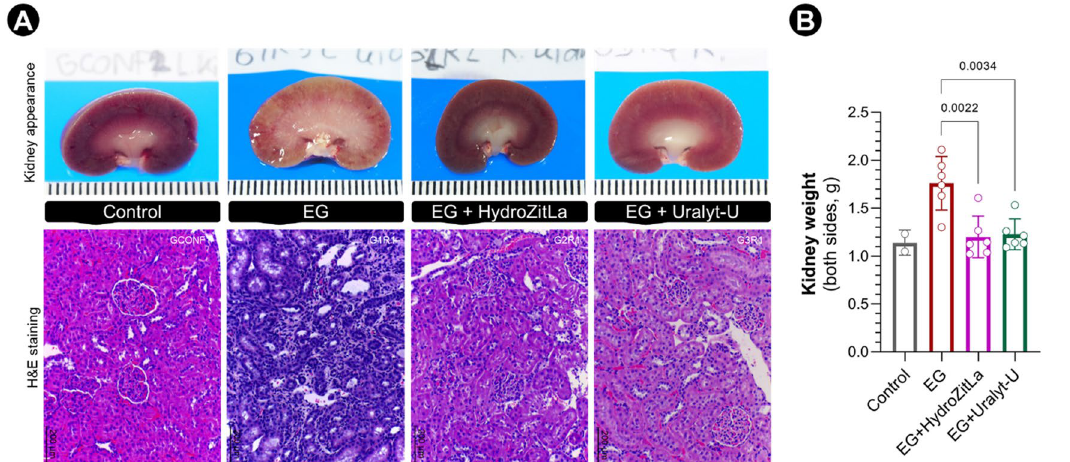
Figure 2. Kidney appearance and H&E staining of rat renal sections. ( A ) Kidney of EG rats were pale, enlarged, and swelled (upper panel). Renal tissues of EG rats had a robust sign of inflammation, but renal tissues of EG + HydroZitLa and EG + Uralyt-U rats appeared normal, similar to that in normal control rats (lower panel). ( B ) The average kidney weights of EG rats were significantly greater than that of EG + HydroZitLa and EG + Uralyt-U rats. Micrograph magnification: ×